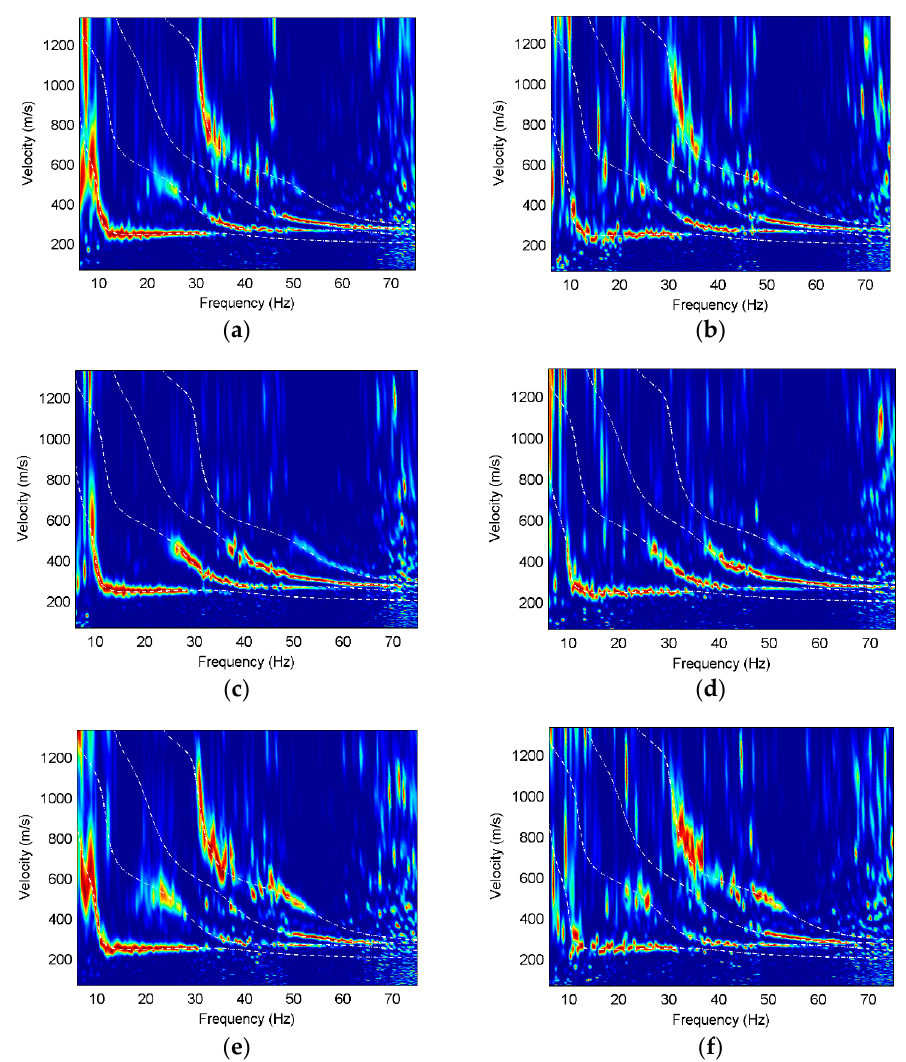
Figure 9. Dispersion images of noisy data of Model 2, where the white dashed lines are the theoretical dispersion curves and the red color represents the maximum energy. SNR of the left column is 2.8 and SNR of the right column is 1.7. ( a ) X component; ( b ) X component; ( c ) Z component; ( d ) Z component; ( e ) R y component; ( f ) R y component.